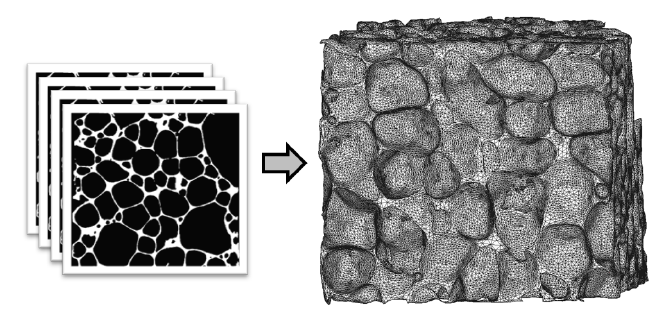
Figure 6. Conversion of binary slices to fully processed 3D